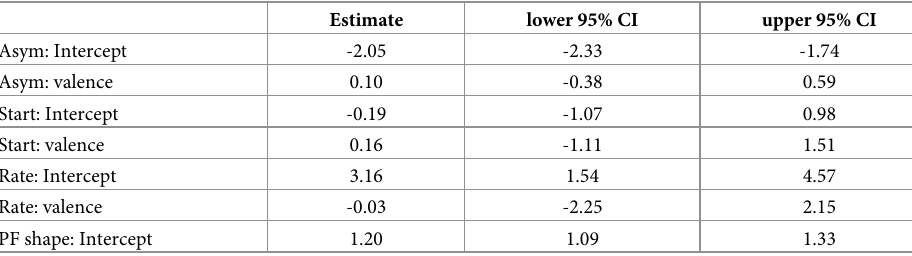
Table 3. Coefficient and CI from model testing valence-manipulation effects in children. Estimate